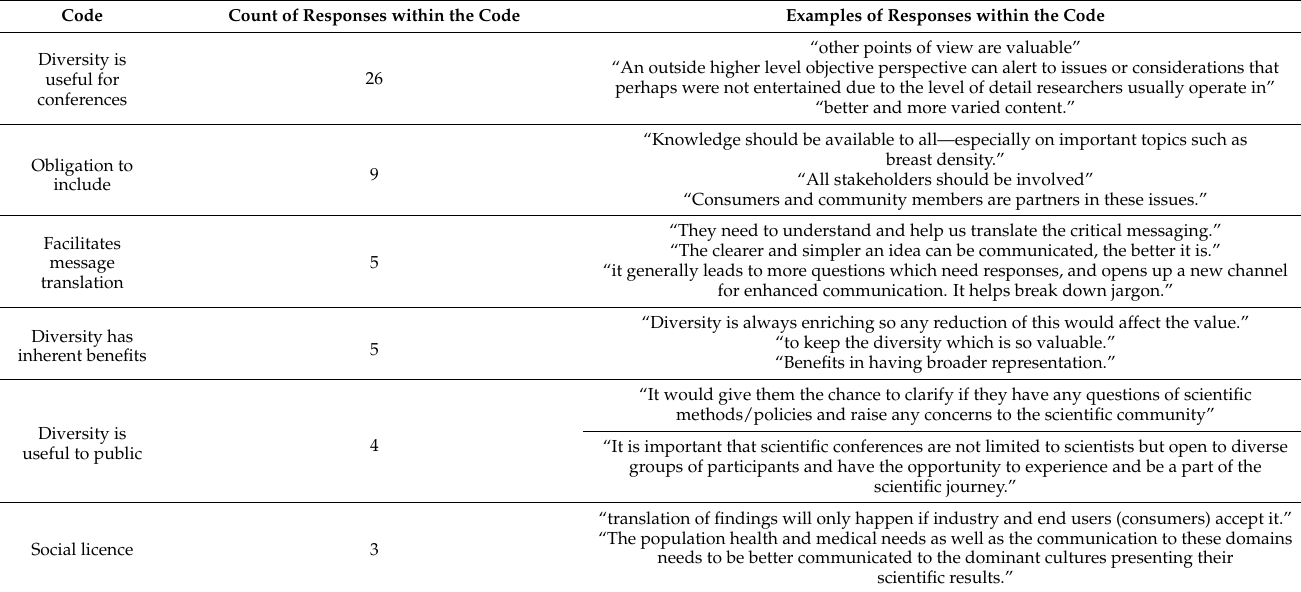
Table 3. Benefits of diverse conference attendees.